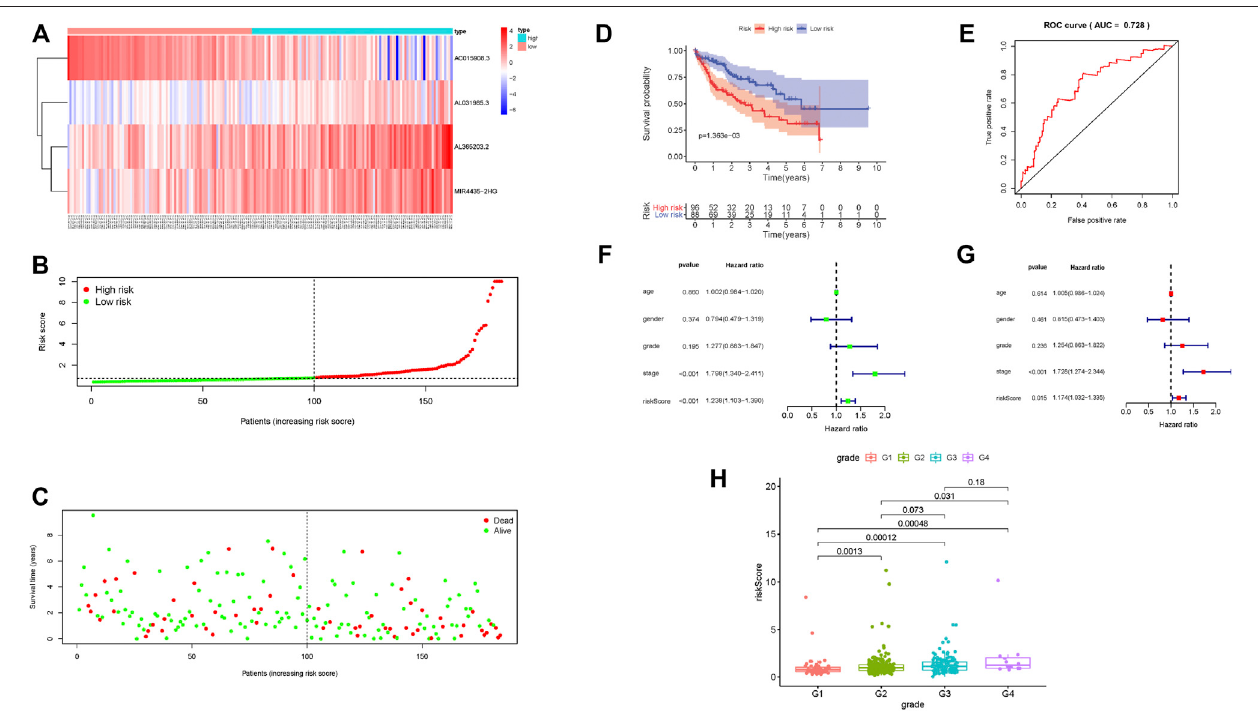
FIGURE 3 | Prognostic risk score characteristics of glycolysis-related lncRNA in the validation set. (A – C) Heat map of the expression of four glycolysis-related lncRNAs in HCC samples, distribution map of risk score, relationship map of survival status and risk score. (D – E) Kaplan – Meier survival curve and ROC curve of high- and low-risk group. (F – G) . Univariate and multivariate Cox regression analysis of clinical features and risk score in HCC samples. (H) Relationship between tumor grade and risk score; risk score signi fi cantly increased for advanced grade